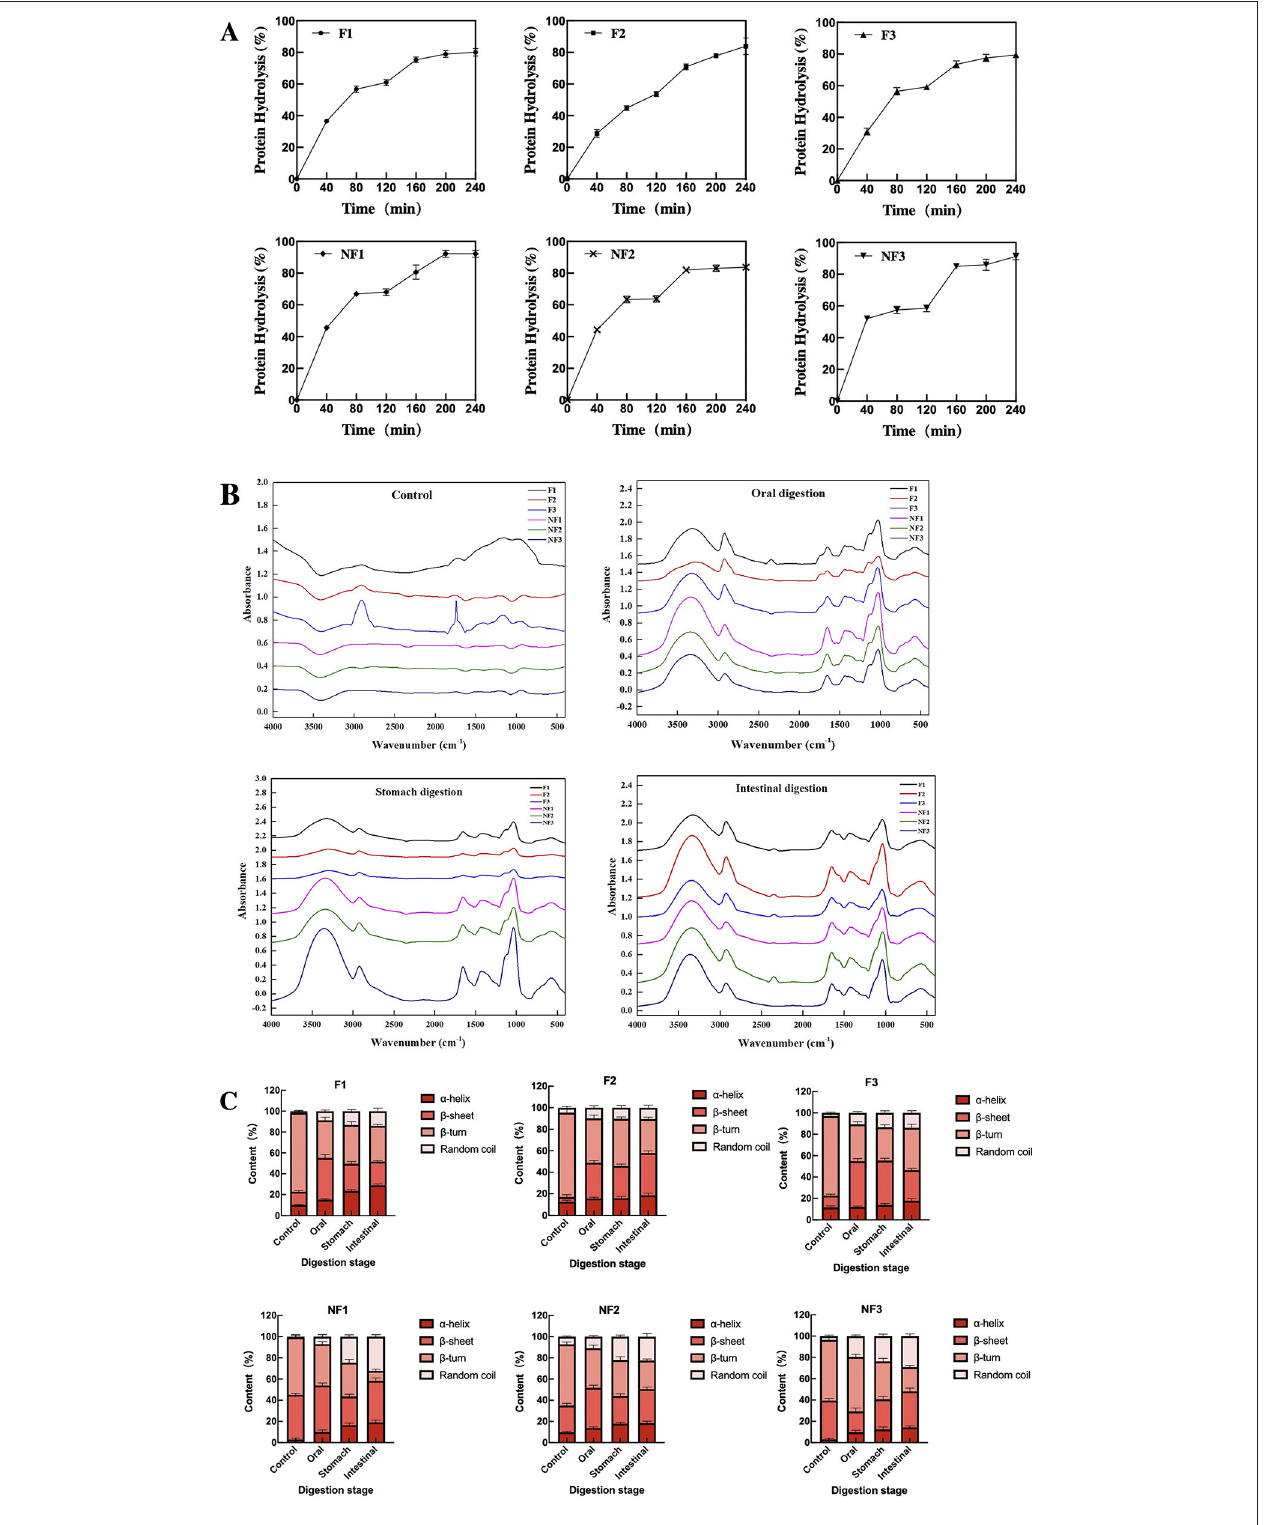
FIGURE 3 | In vitro protein digestibility of fried and non-fried instant noodle products. (A) Protein hydrolysis rate of F1, F2, F3, NF1, NF2, and NF3, respectively; (B) FT-IR spectra during the phases of the untreated, oral, stomach, and intestine; (C) protein secondary structure changes during in vitro protein digestion.